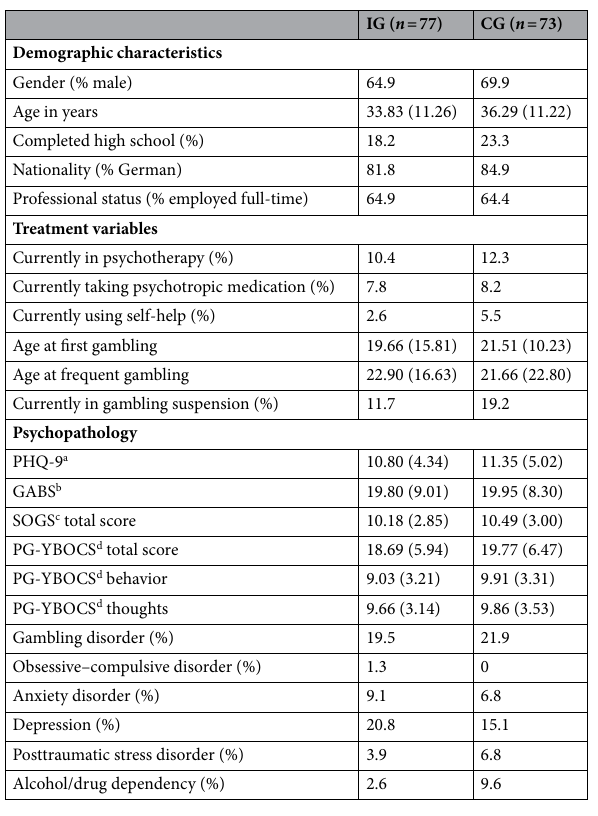
Table 1. Baseline characteristics (intention-to-treat sample), frequency, means, and standard deviation (in brackets). a PHQ-9: Patient Health Questionnaire–9. b Gambling Attitudes and Beliefs Survey. c South Oaks Gambling Screen. d Pathological Gambling Adaptation of Yale-Brown Obsessive Compulsive Scale.